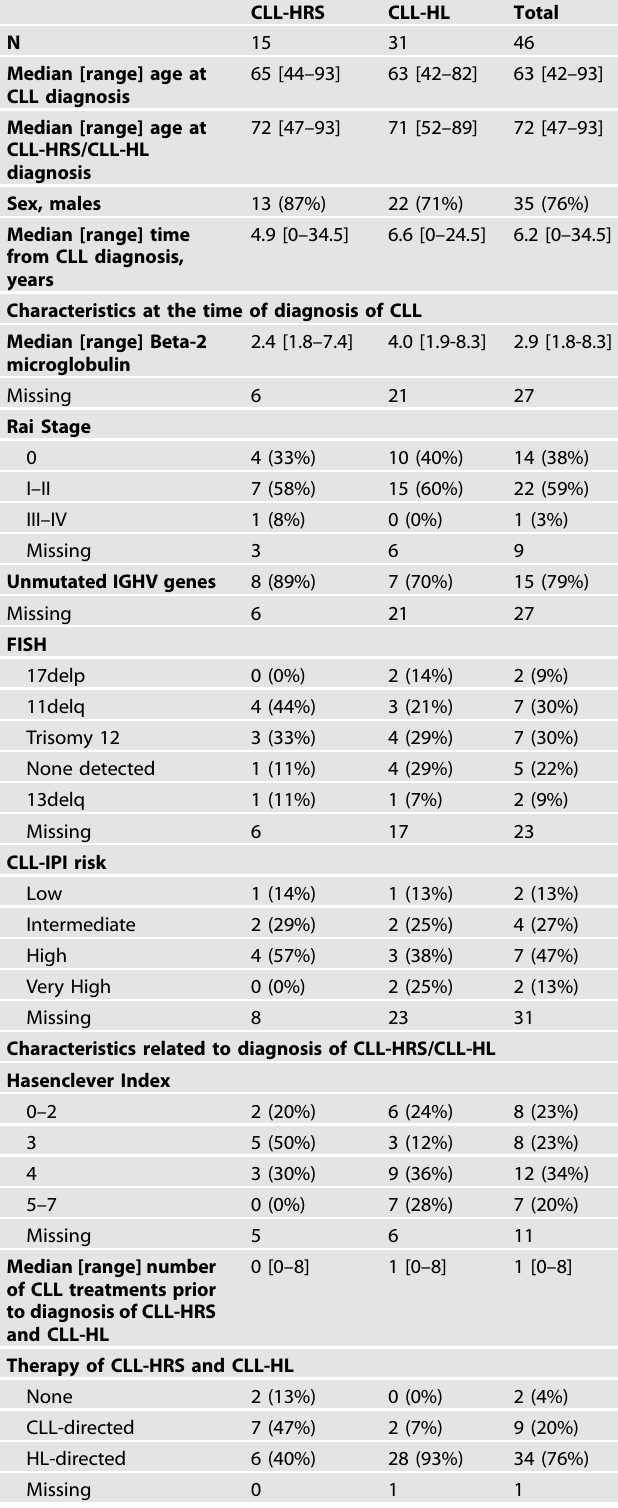
Table 1. Patient characteristics.